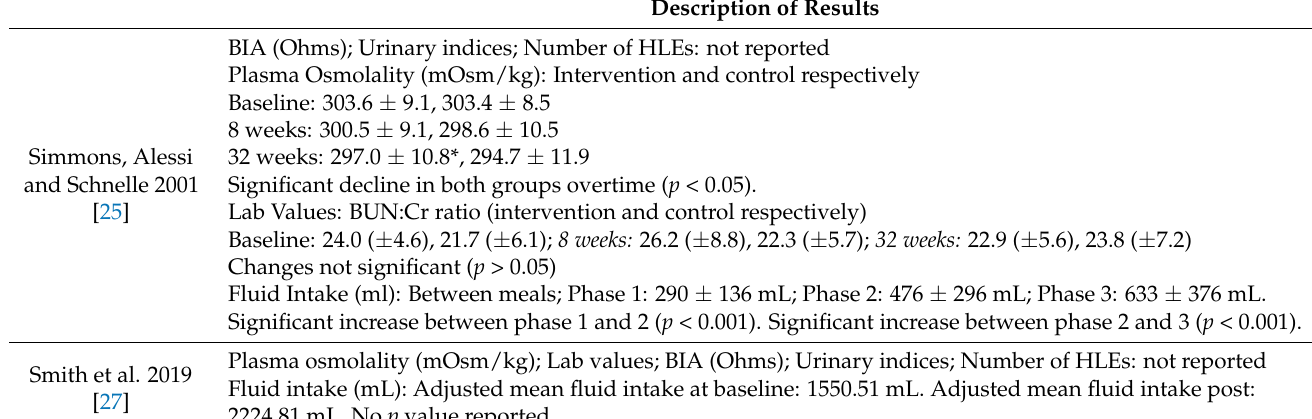
Table 3. Cont. Description of